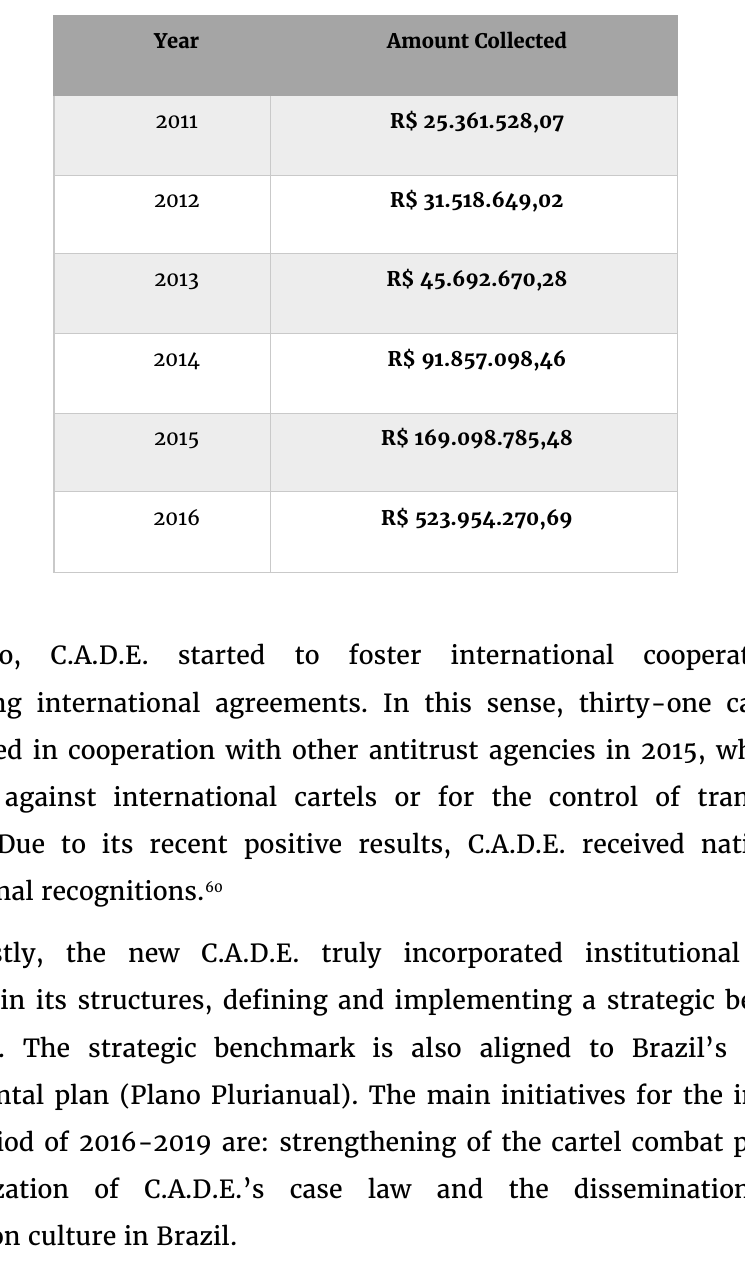
Table 2. Total of Fine Collected per year by